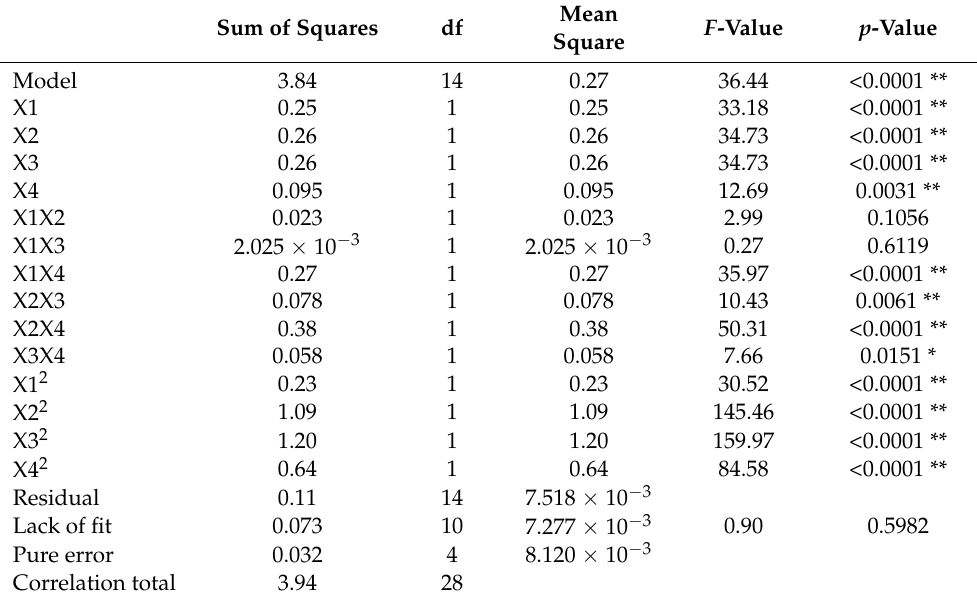
Table 2. Analysis of the variance for the fitted second-order polynomial model for microwave-assisted deep eutectic solvent